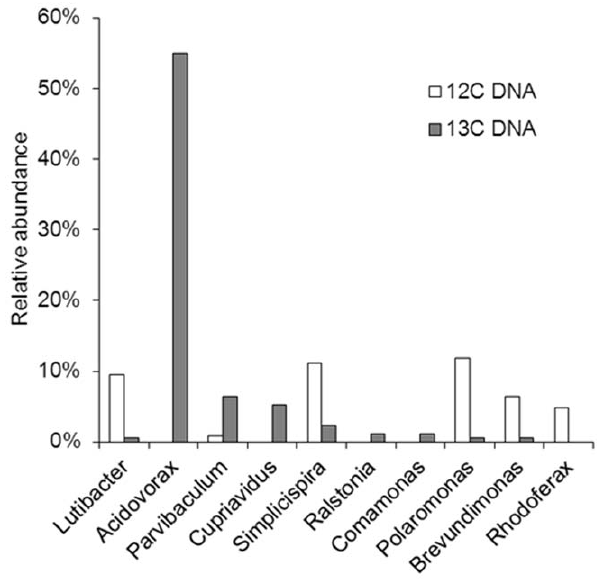
Figure 3. Taxonomic assignments of the microbial communi- ties in the 12 C- and 13 C-DNA fractions revealed by pyrosequen- cing. Relative abundance of the species as a % of total 16S-rRNA reads is